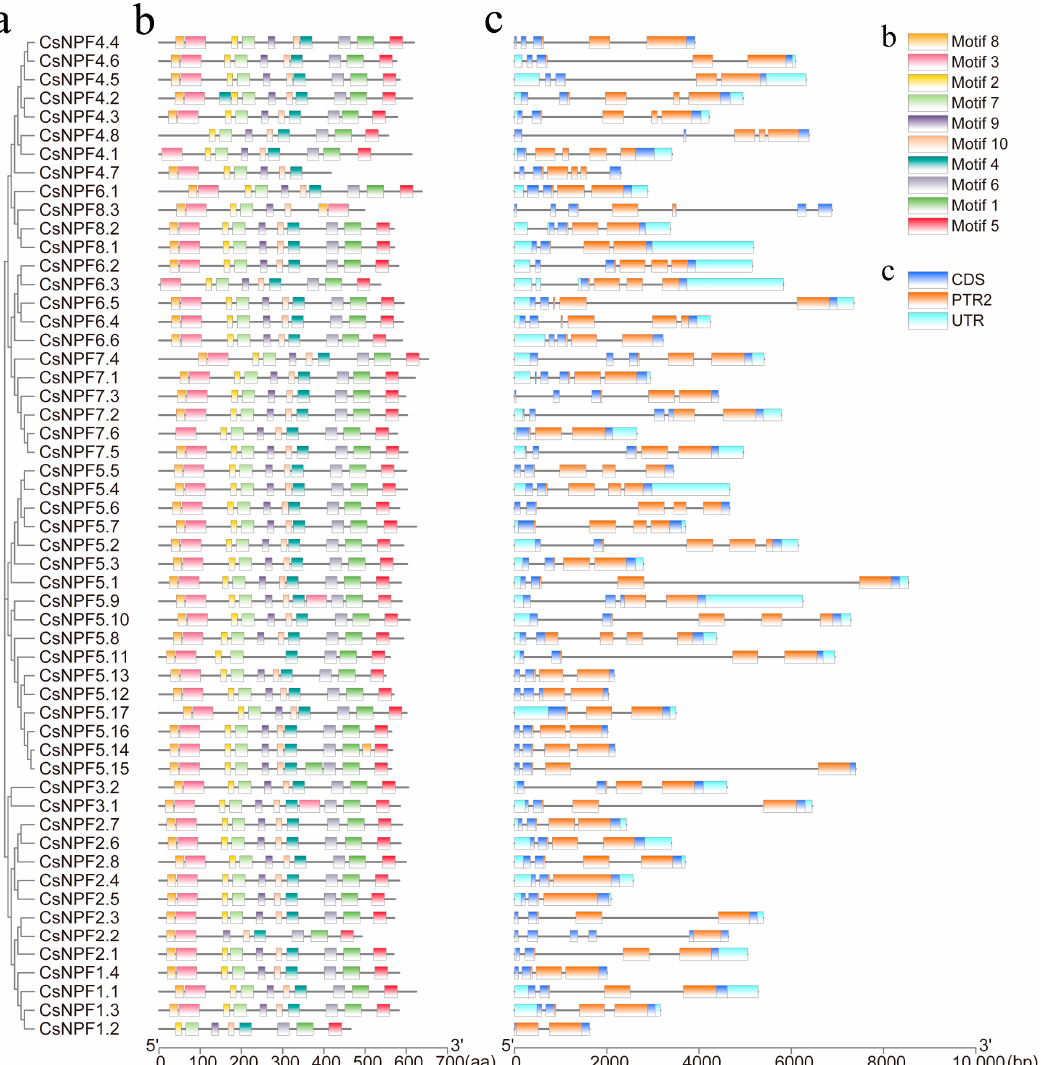
Figure 3. Phylogenetic relationships, conserved protein motifs, and gene structure of CsNPF genes. ( a ) Phylogenetic tree of the CsNPF gene family. ( b ) Conserved motif analysis of CsNPF protein se ‐ quences. Each motif is represented by a specific color. ( c ) Gene structure and domain analyses of CsNPF genes. PTR2 domain, CDS and UTR, which are indicated by orange, dark blue, and wathet boxes, respectively.